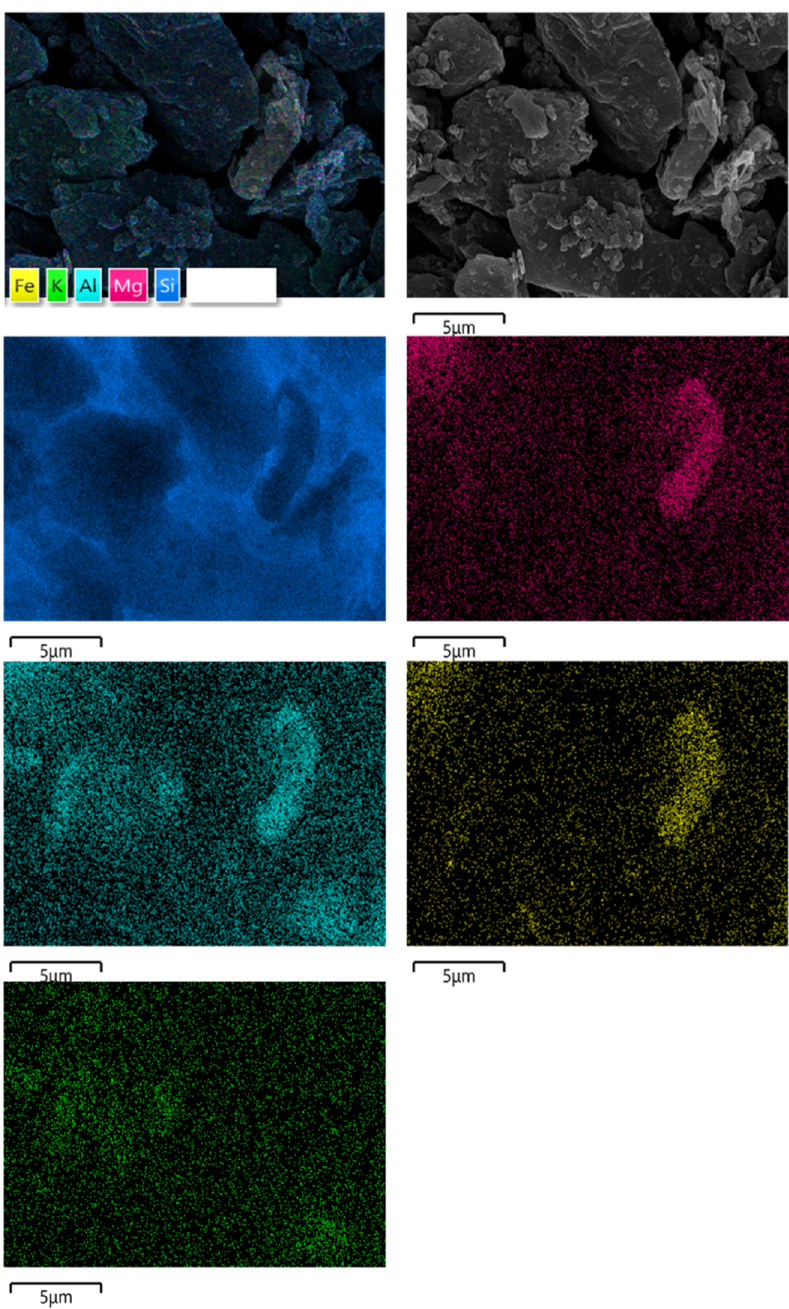
Figure 2. SEM and EDS analysis of raw graphite ore. Table 1. EDS elemental analysis of graphite.